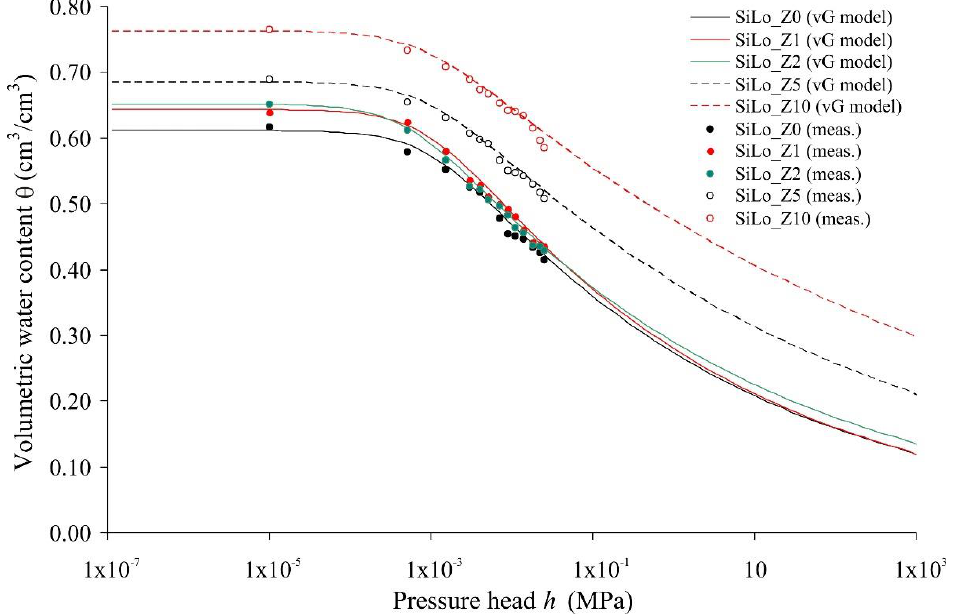
Figure 4. Experimental soil water retention curves (SWRCs) and modeled Equation (1) (van Genuchten, vG model) with reference to the selected soil–zeolite mixtures: SiLo_Z0=soil without zeolite; SiLo_Z1=soil with 1% of zeolite; SiLo_Z2=soil with 2% of zeolite; SiLo_Z5=soil with 5% of zeolite; SiLo_Z10=soil with 10% of zeolite.